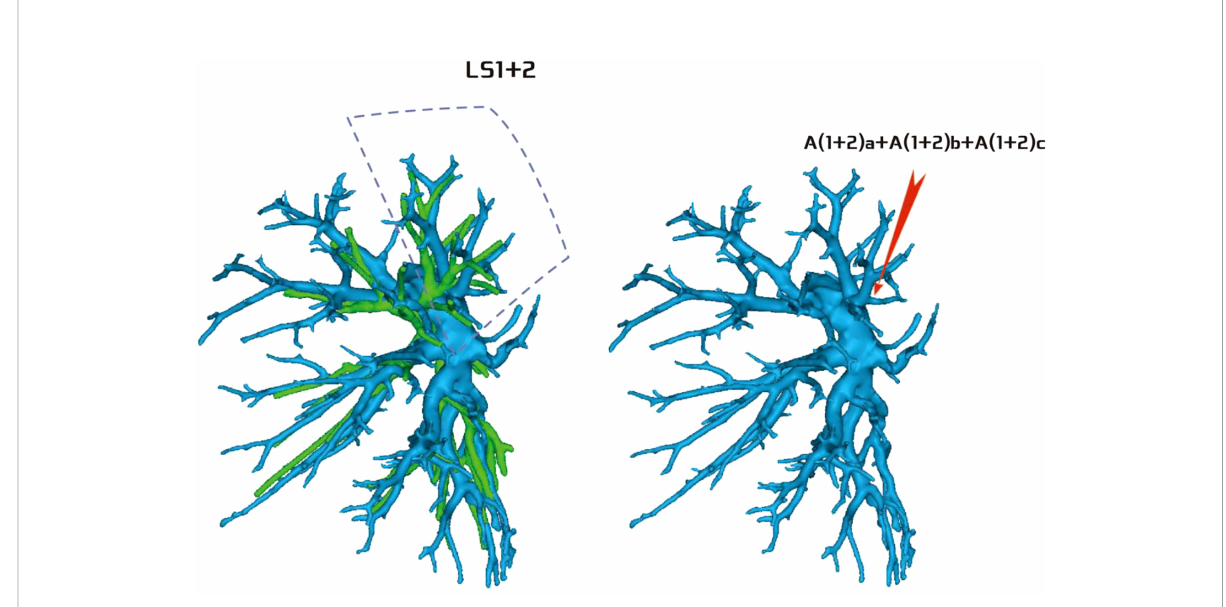
FIGURE 7 Type IV: Dotted line is the LS1 + 2 area, and A(1 + 2)a, A(1 + 2)b, and A(1 + 2)c are